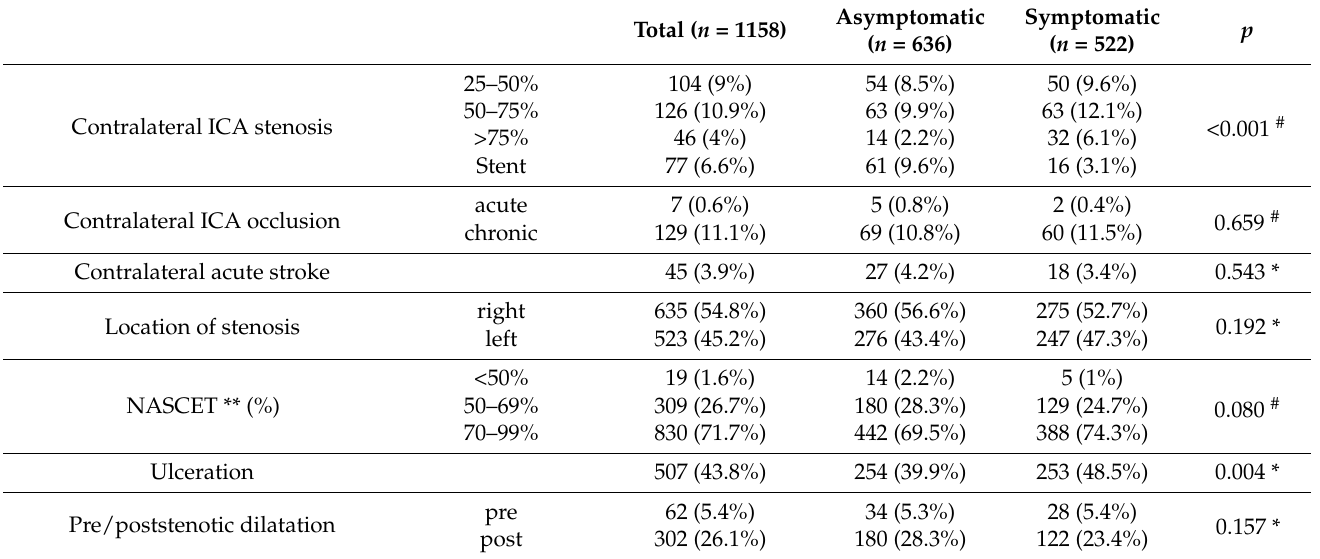
Table 4. Anatomical data.